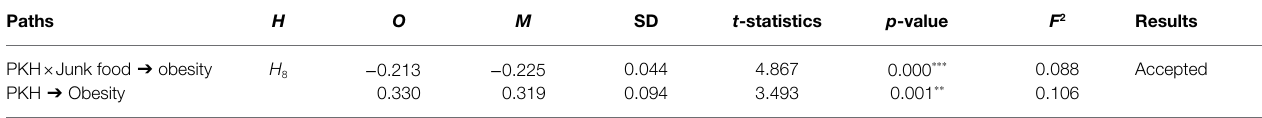
TABLE 7 | Moderating effects. Paths